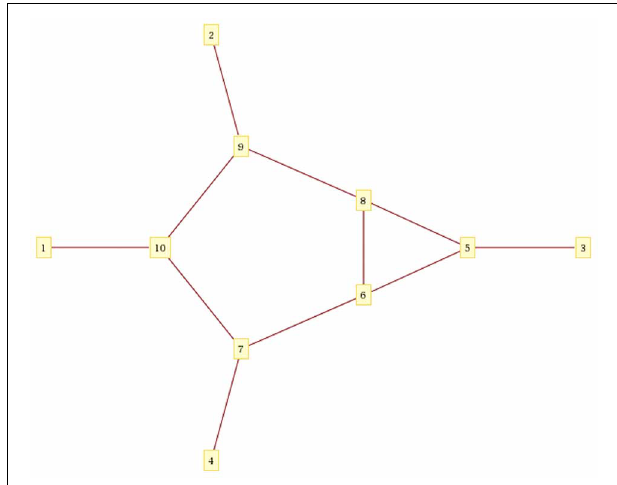
FIGURE A1 | Mathematica version of Figure 1 recombinant